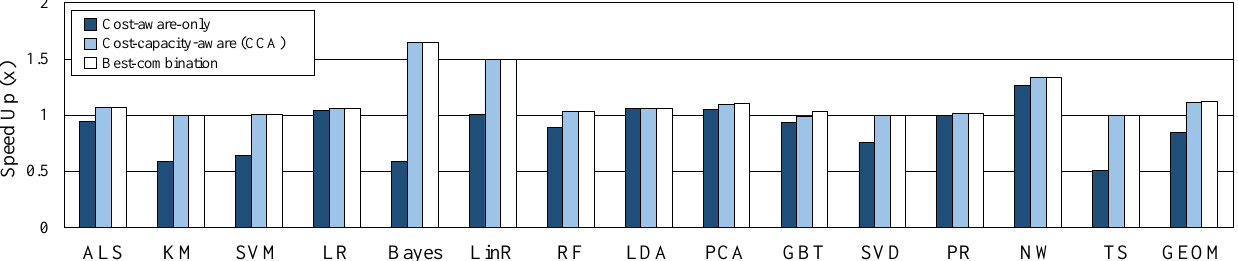
Figure 9. Comparison of three methods on reduced cache